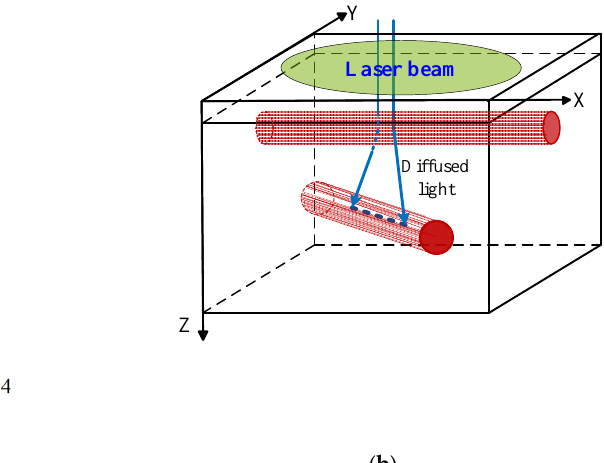
Figure 12. Simplified skin model embedded with cross-bridge vessels.